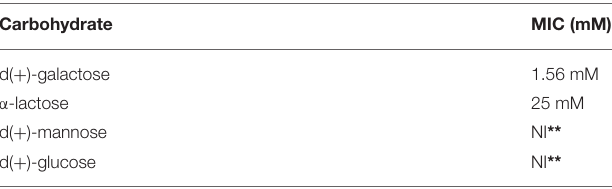
TABLE 1 | Inhibition assay of hemagglutination activity showing a minimum inhibitory concentration (MIC) of the carbohydrates tested. Carbohydrate